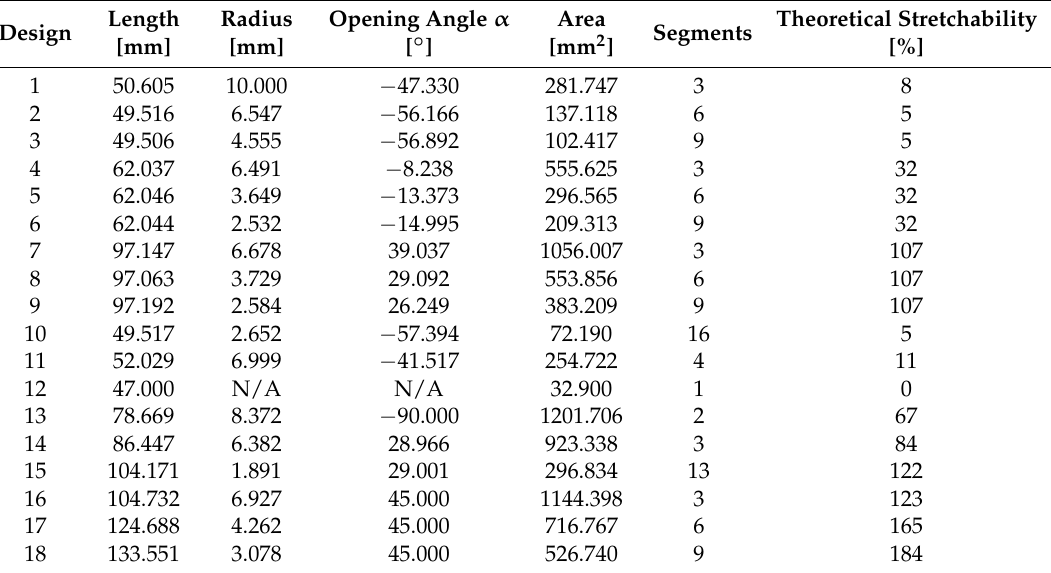
Table 1. Design parameters for the tested interconnects.